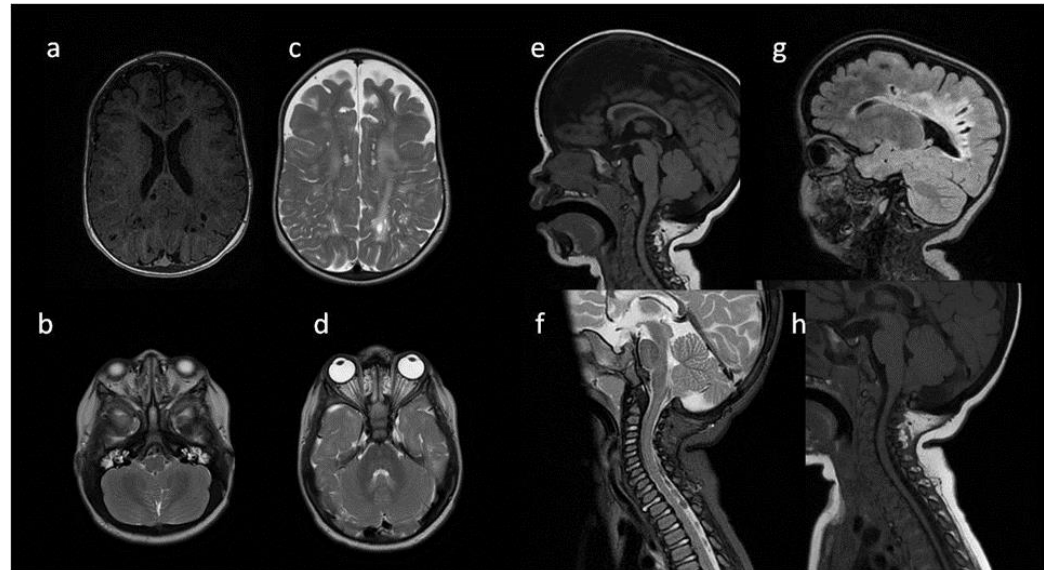
Figure 4. Brain MRI. Patient 4, 1st exam. ( a – d ) axial T1 & T2; ( e – h ) sagittal T1, T2, Flair T2, T1. Findings: ( a , c , g ) enlarged periventricular spaces with characteristic location in corpus callosum; ( a , c , g ) abnormal white matter signals; ( b ) posterior fossa horns, mastoid cells fluid; ( d ) optic nerve sheath enlargement, ethmoid sinus fluid; ( e , f , h ) J-shaped sella turcica, dysplastic dens; ( e , g ) skull deformation.